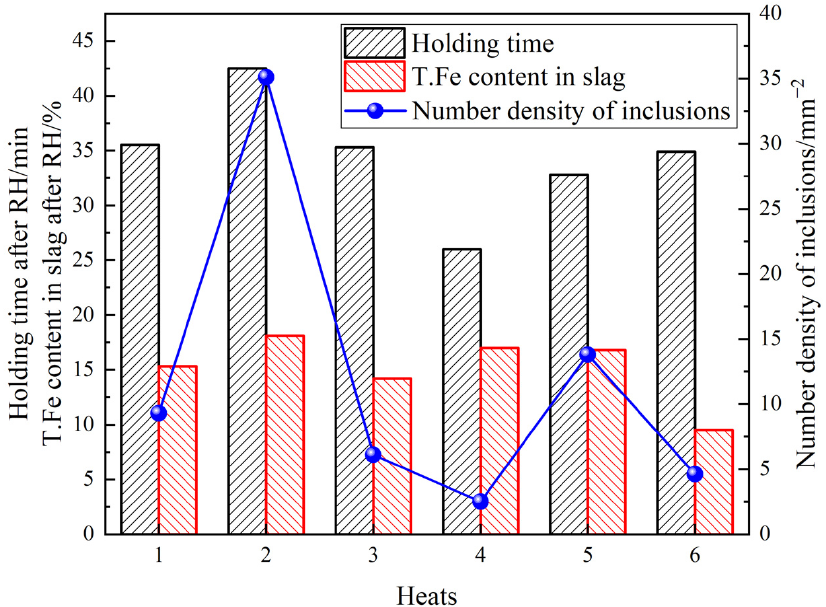
Figure 18. Changes in number density of inclusions, T.Fe content after RH and holding time in different heats.